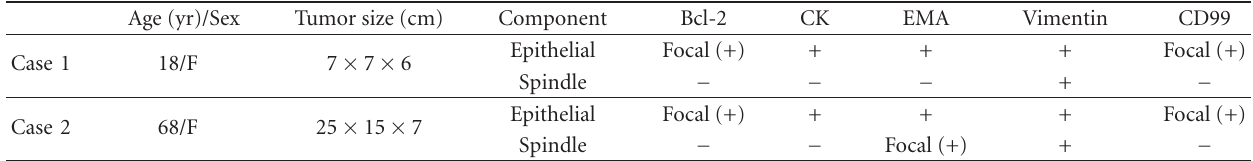
Table 1: Clinical and immunohistochemical data of the two